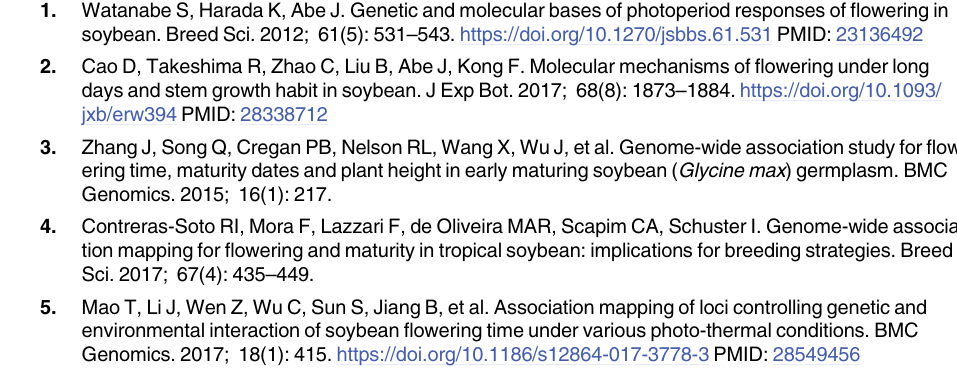
S1 Table. Primer sequences for gene-specific DNA markers and expression analyses used in this study. S2 Table. Annotated genes in the intervals of the left and right markers of QTLs for days to flowering. S3 Table. DNA polymorphisms in the genomic region of FT2a between AGS292 and